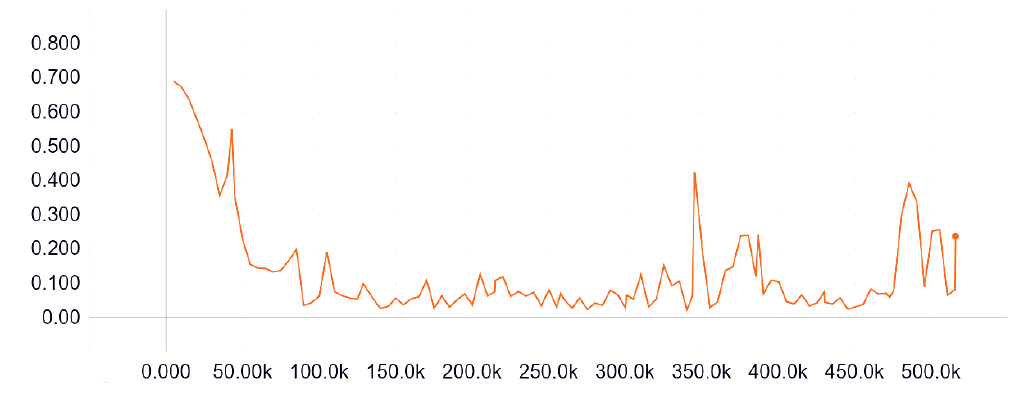
Figure 5. Training loss curve represented loss value per thousand